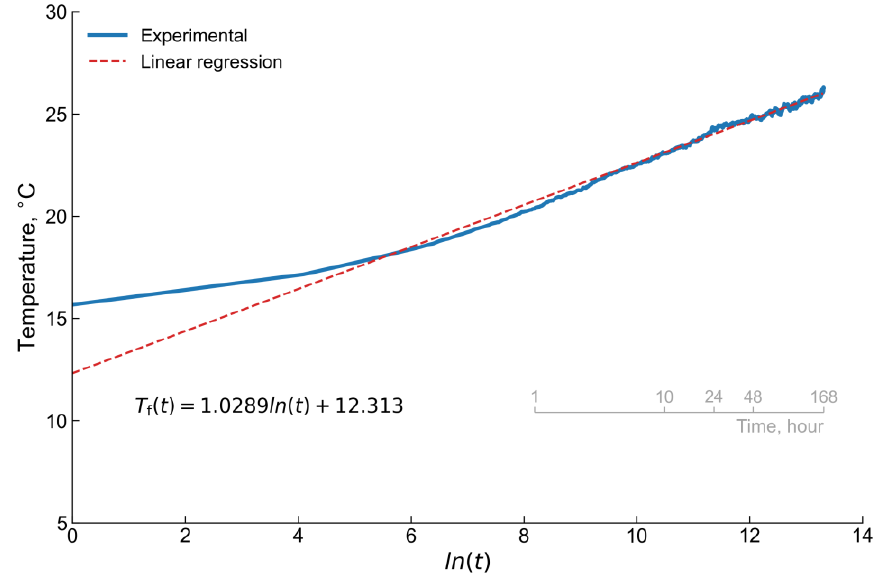
Figure 8. Regression line for temperature vs. time (full time, 7 days).